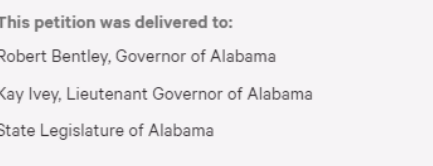
Figure 1: Example